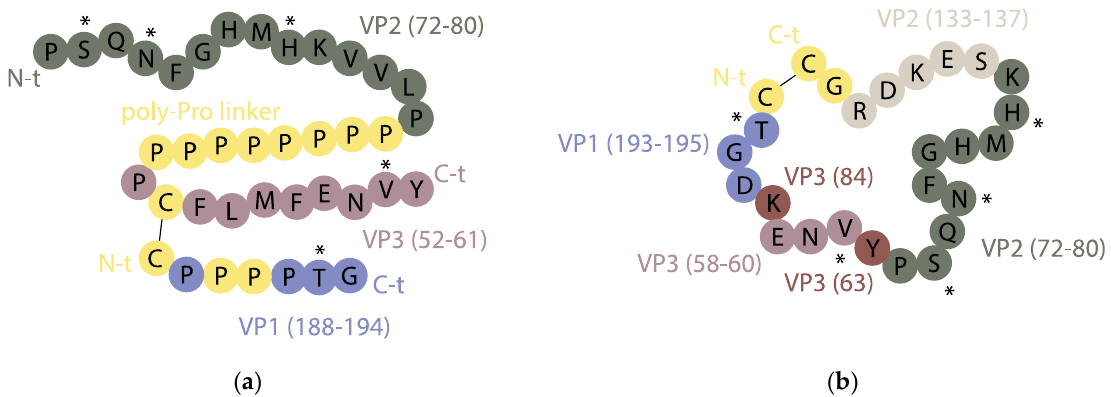
Figure 4. Overview of two synthetic peptides mimicking discontinuous site D of FMDV serotype C using ( a ) a cross-sectional view of the critical residues, with the VP2 and VP3 fragments containing them linked by means of a polyproline helix, and the VP1 segment attached to the VP3 one by a disulfide bond [116]; ( b ) a front view that favors display of surface-exposed antigenic residues [117]. The five critical residues of discontinuous site D are labeled by an asterisk (*) and non-native residues are in yellow. Adapted from